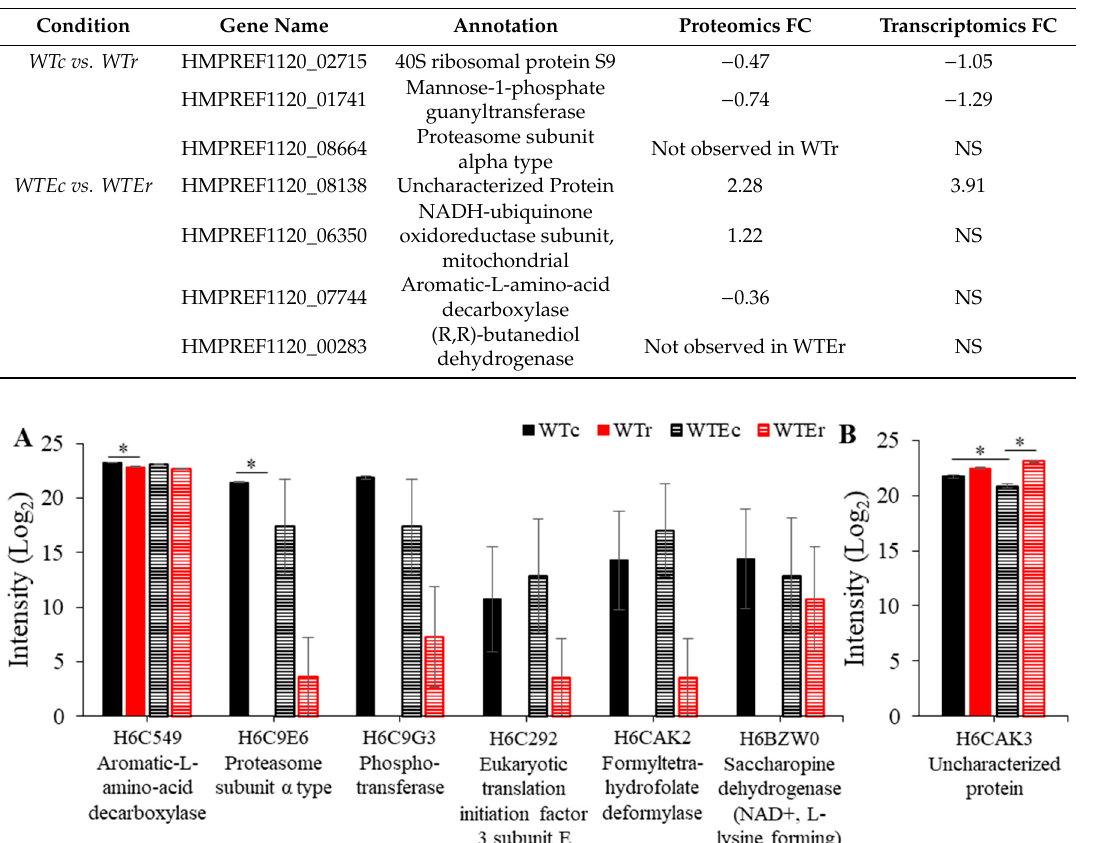
Figure 3. Intensity levels of proteins decreased ( A ) and increased ( B ) after irradiation in both WT and evolved strains. Error bars represent standard error. Asterisks indicate instances of statistically significant comparisons. Table 1. List of proteins found in significantly different relative amounts after irradiation in WT and Evolved (WTE) strains, along with their predicted functions and the Log 2 Fold Change (FC) values for the given comparison in both the current proteomic experiment and our prior transcriptomic experiment [9] . NS = not significant. Not observed = protein was not observed in the specified sample so a fold change in relative amount cannot be calculated.